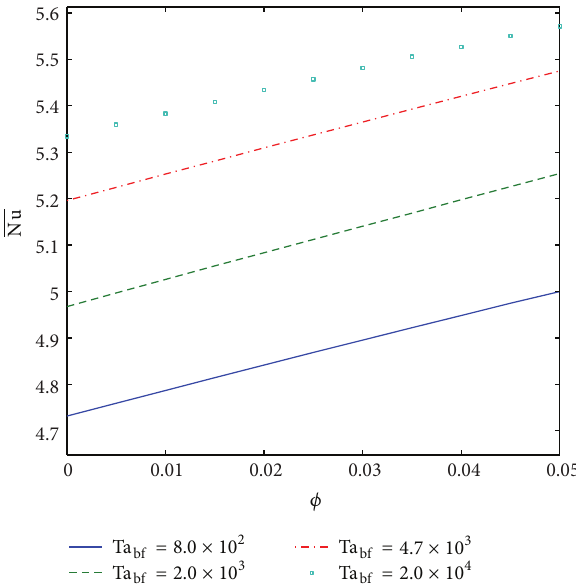
Figure 7: Plots of the average Nusselt number against 𝜑 for the values of Ta bf labeled on the figure with 𝜙 = 0.05 for water-Cu.